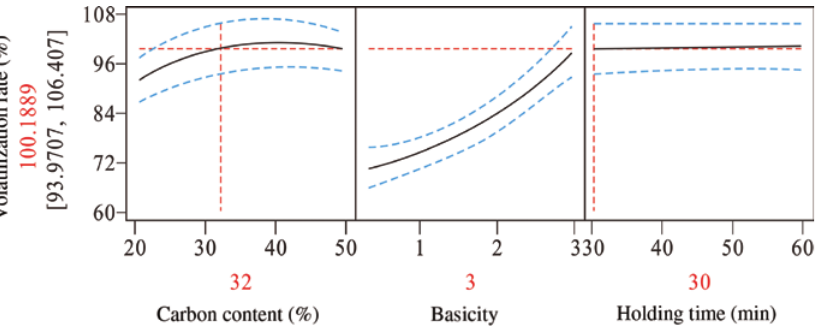
Figure 1: Prediction profiler for the zinc volatilization